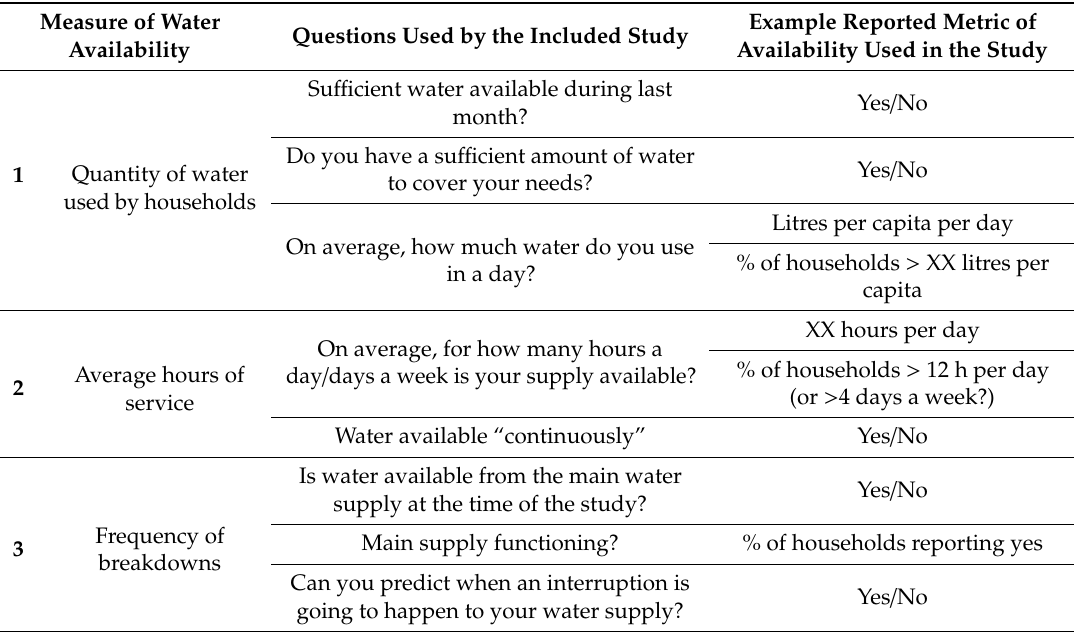
Table 1. Measures of water